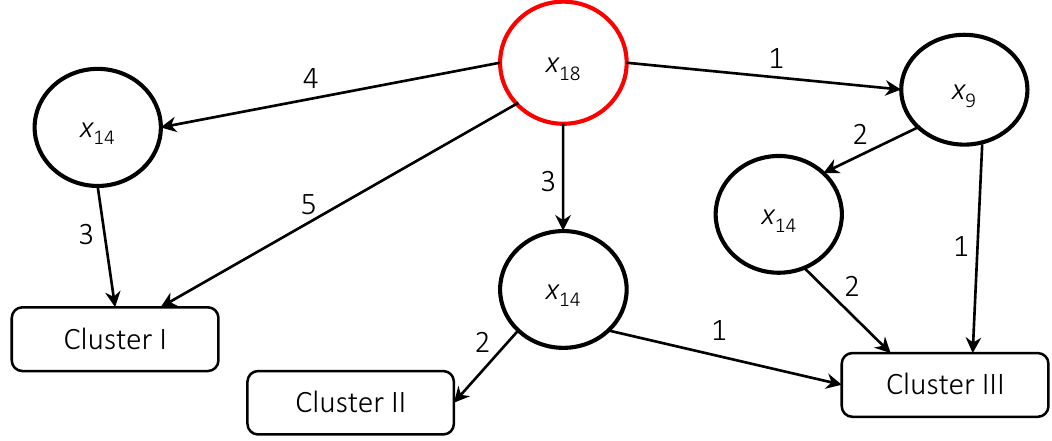
Figure 1. Cognitive model for managing the NIS parameters of the EU